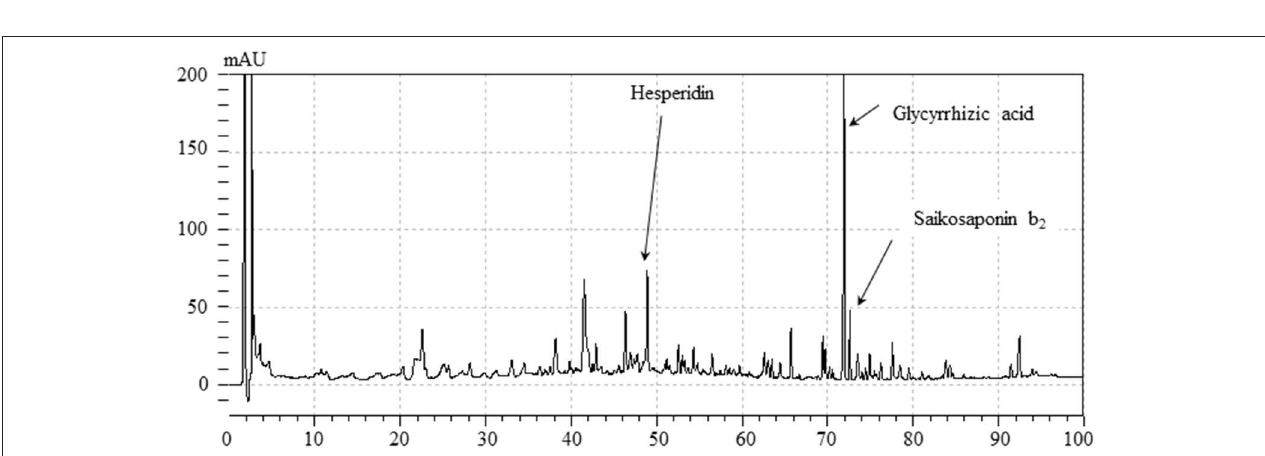
FIGURE 2 | HPLC profile of YKSCH.Each chemical marker (Saikosaponin b 2 , hesperidin, glycyrrhizic acid) in the HPLC profile was identified by comparison with retention times and UV spectra (245nm) of their reference